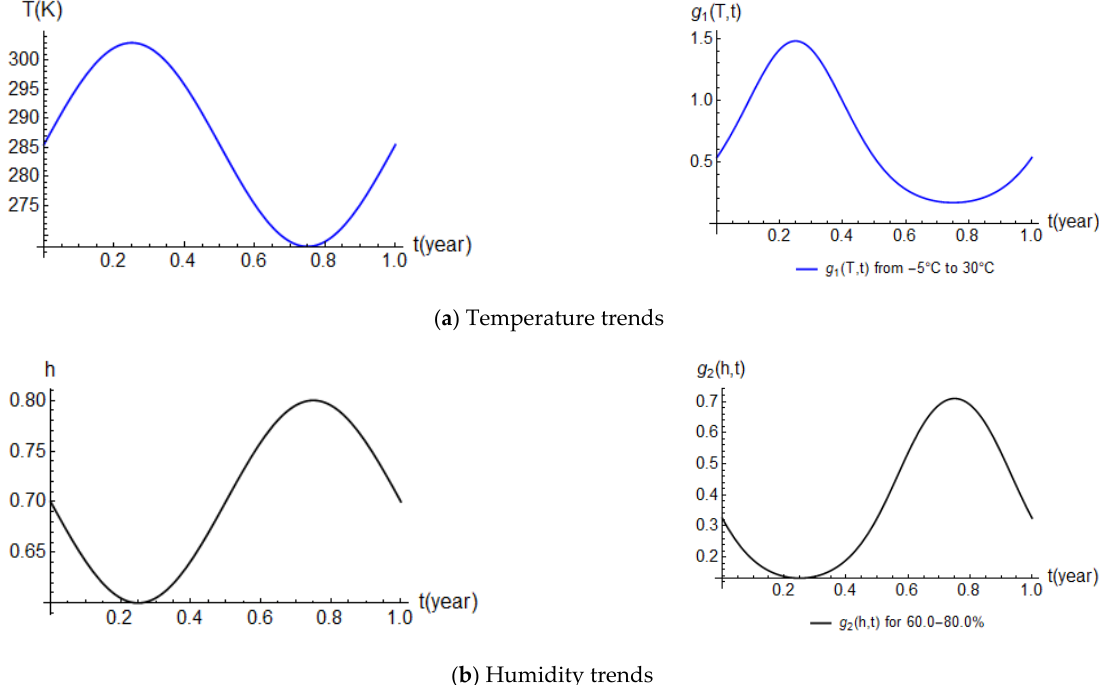
Figure 4. Function trends described by ( a ) Equation (16) and ( b ) Equation (17).